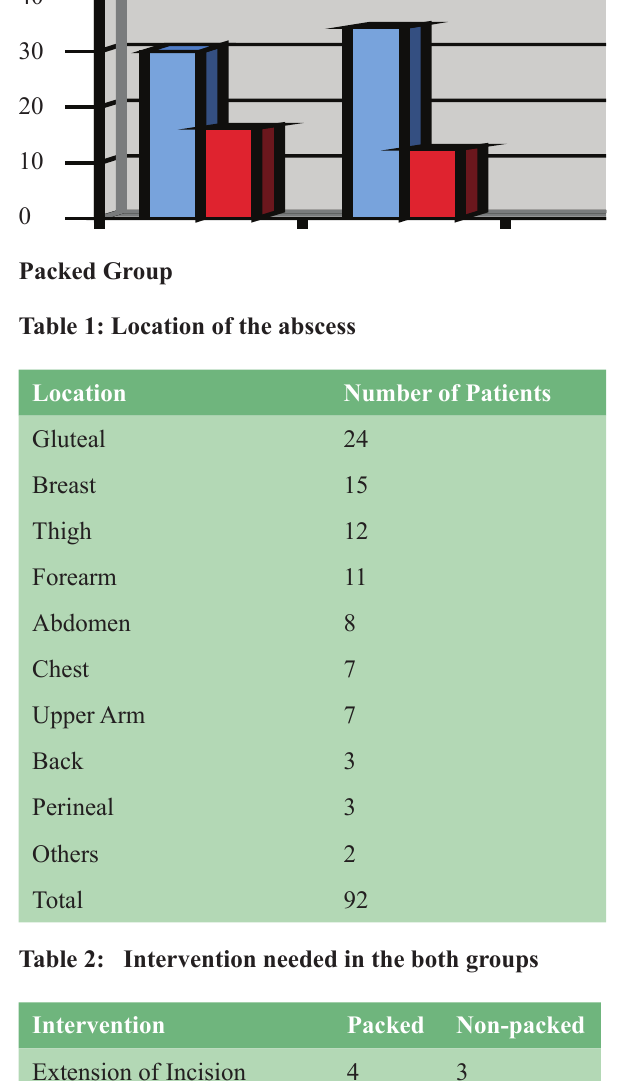
Table 4: Use of pain